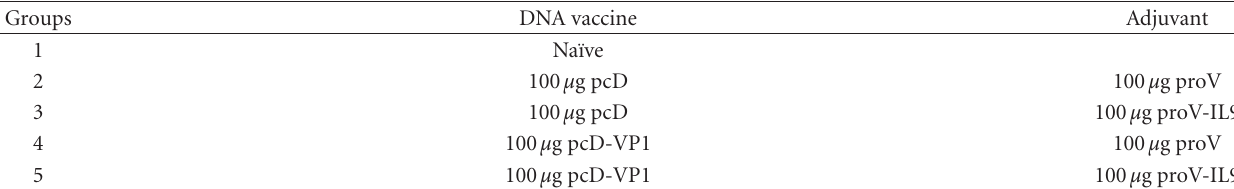
Table 1: Immunization